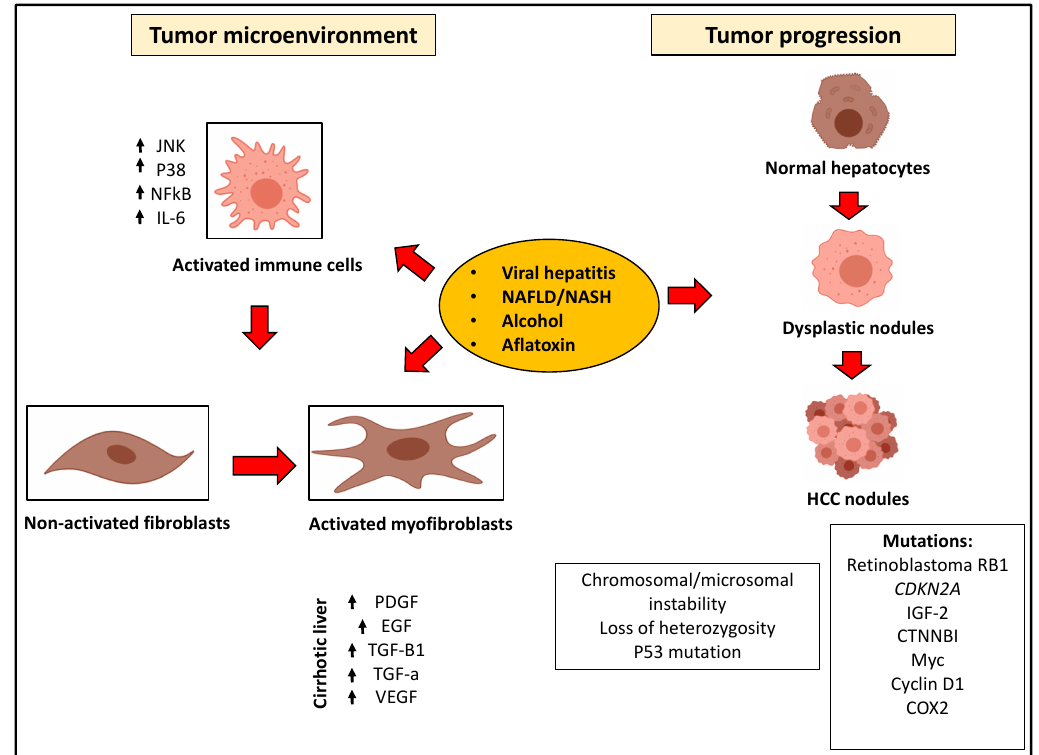
Figure 1. Mechanisms of hepatocellular carcinoma. Molecular pathways of HCC carcinogenesis are summarized. Risk factors include viral hepatitis, NAFLD, alcohol and toxins. HCC tumors develop as dysplastic nodules through the gaining of molecular aberrations and mutations. The cirrhotic microenvironment in the liver promotes HCC carcinogenesis through the activation of hepatic stellate cells into myofibroblasts. The cirrhotic background also promotes inflammation leading to the upregulation of pro-carcinogenic genes and pathways (text for details).